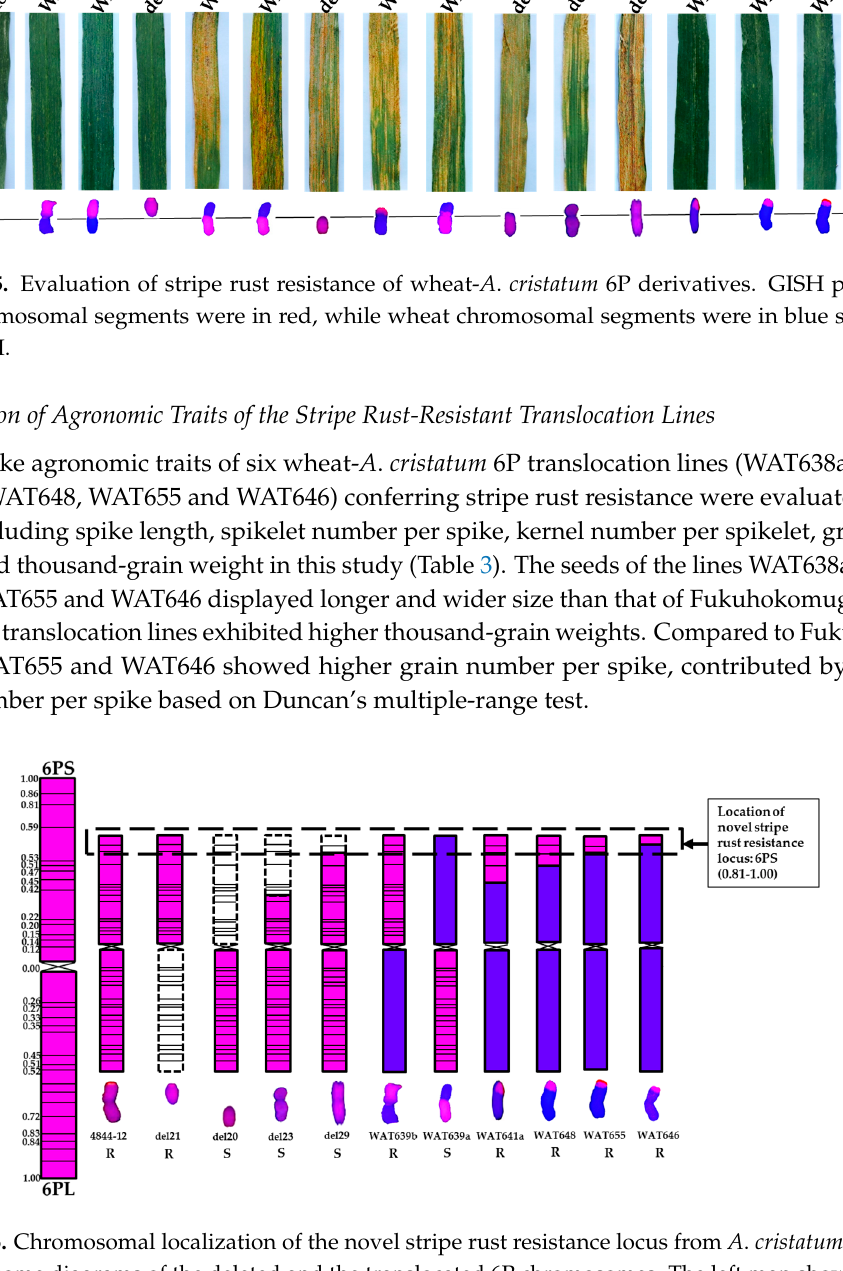
chromosome diagrams of the deleted and the translocated 6P chromosomes. The left map showed that